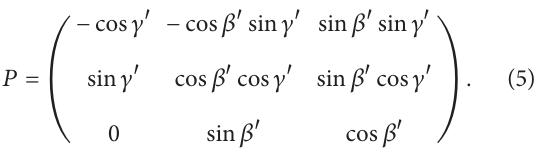
is included already in the parameter Δ𝛽 𝑒 . The deviation in plane (𝑢, 𝑤) is described by the angle 𝜉 . Thus, in the local reference system the deviated normal vector can be expressed as ̂𝑛 𝑒 = (− sin 𝜉, 0, cos 𝜉) . To obtain this vector in the global reference system a rotation should be applied